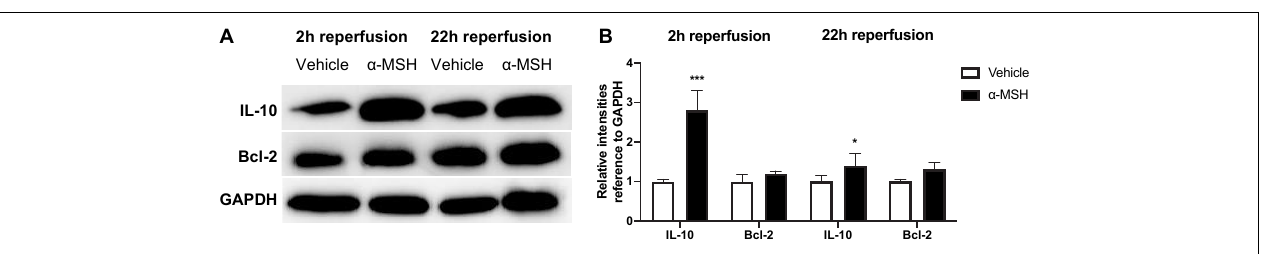
FIGURE 6 | α -MSH increased expressions of anti-inflammatory and pro-survival proteins after I/R injury. (A,B) Protein expressions of IL-10 was significantly higher in animals treated with α -MSH at 2 h and 22 h of reperfusion. (A,B) Although Bcl-2 expression was higher in animals treated with α -MSH in both experimental conditions, the expression was comparable. * P < 0.05, *** P < 0.001, Independent samples t -test, n = 5–6 for each